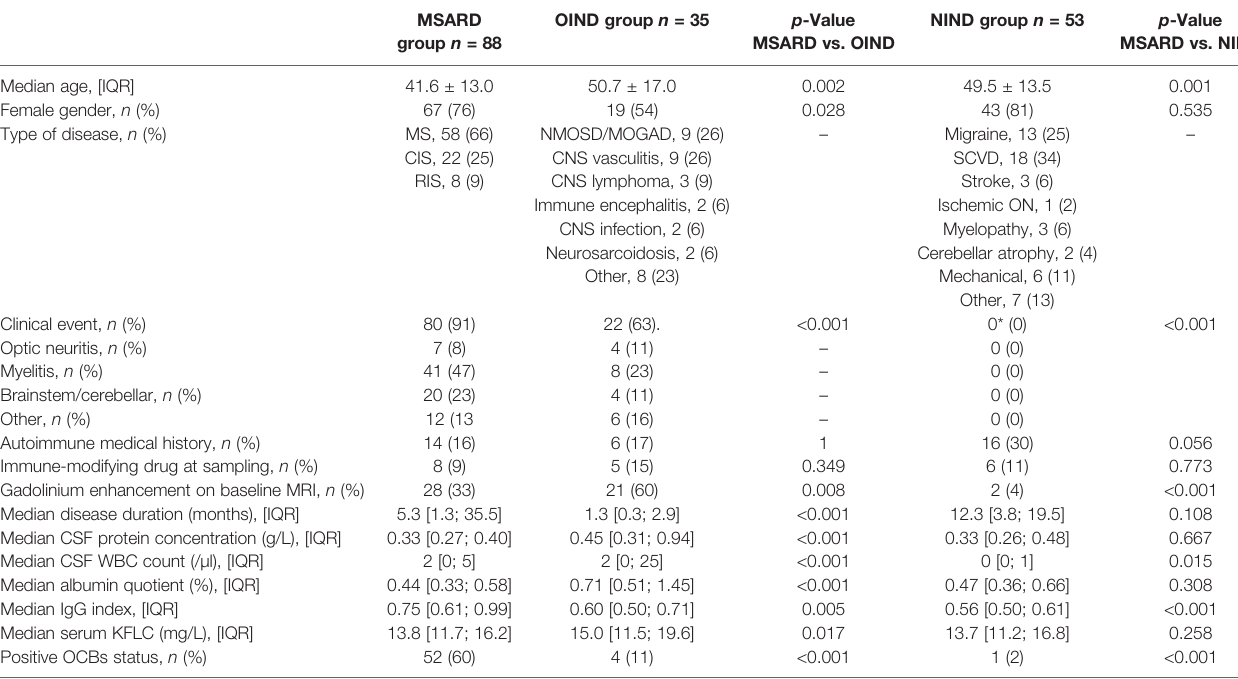
TABLE 1 | Baseline demographic and clinical